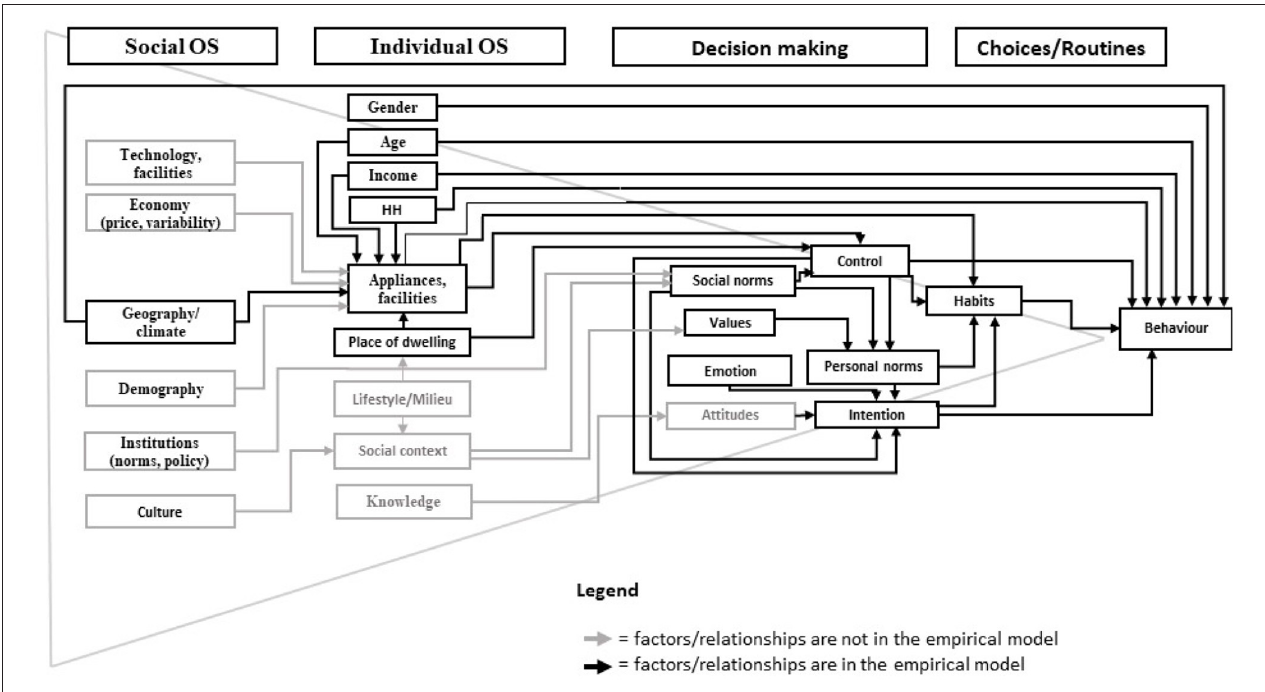
FIGURE 3 | Empirical implementation of the model.